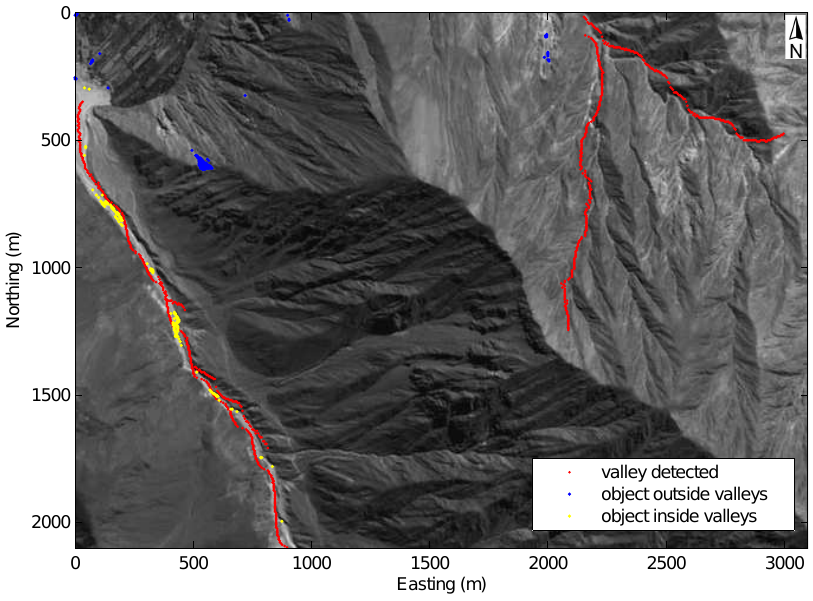
Figure 4. Valleys detected by the automatic procedure (red points). Objects identified as inside these valleys are removed (yellow points). Remaining blue points are candidates for being